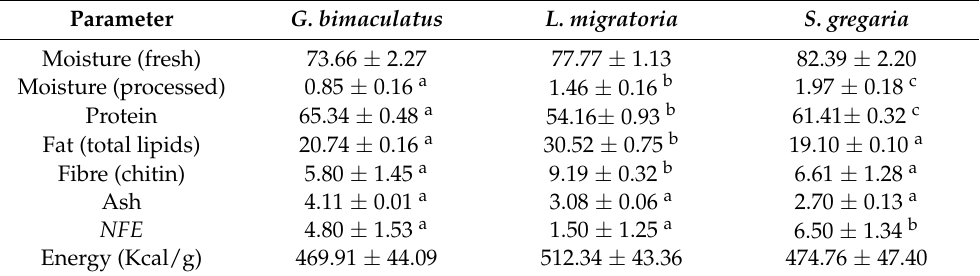
Table 2. Proximate composition of oven-dried G. bimaculatus , L. migratoria , and S. gregaria (based on a dry matter basis except for the moisture content of fresh samples): each value represents the mean ± standard deviation of triplicate determinations (except for moisture contents, n = 5).